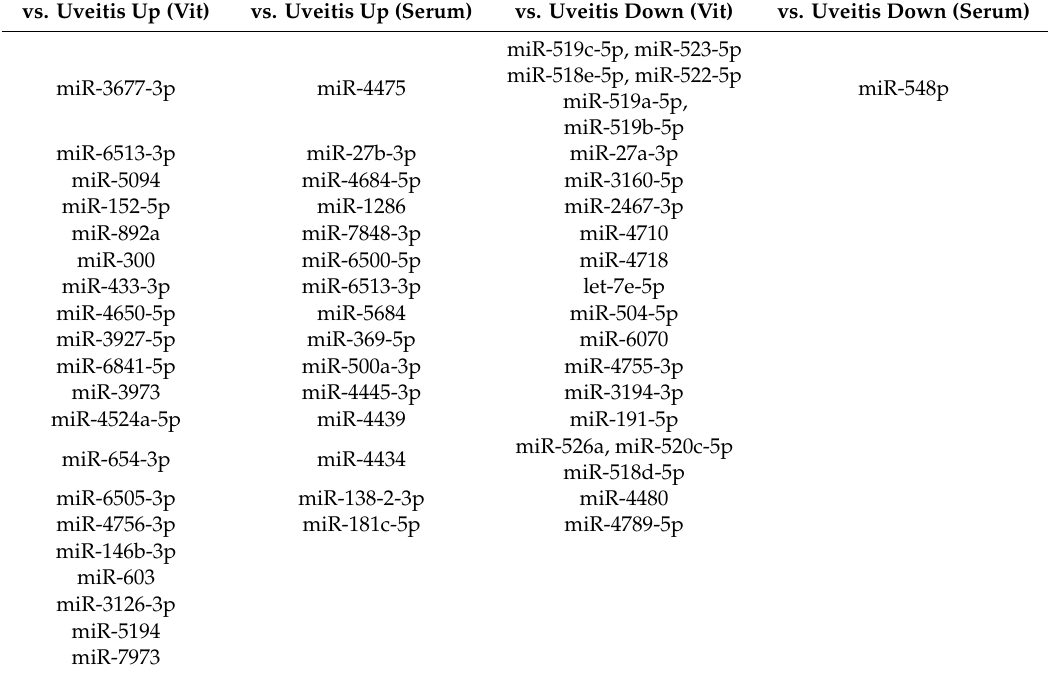
Table 3. Vitreous and serum miRNAs modulated in vitreoretinal lymphoma versus uveitis with vitreous opacity [for uveitis up (vitreous) - the top 20 are shown] ( p < 0.05). vs. Uveitis Up (Vit) vs. Uveitis Up (Serum) vs. Uveitis Down (Vit) vs. Uveitis Down (Serum)